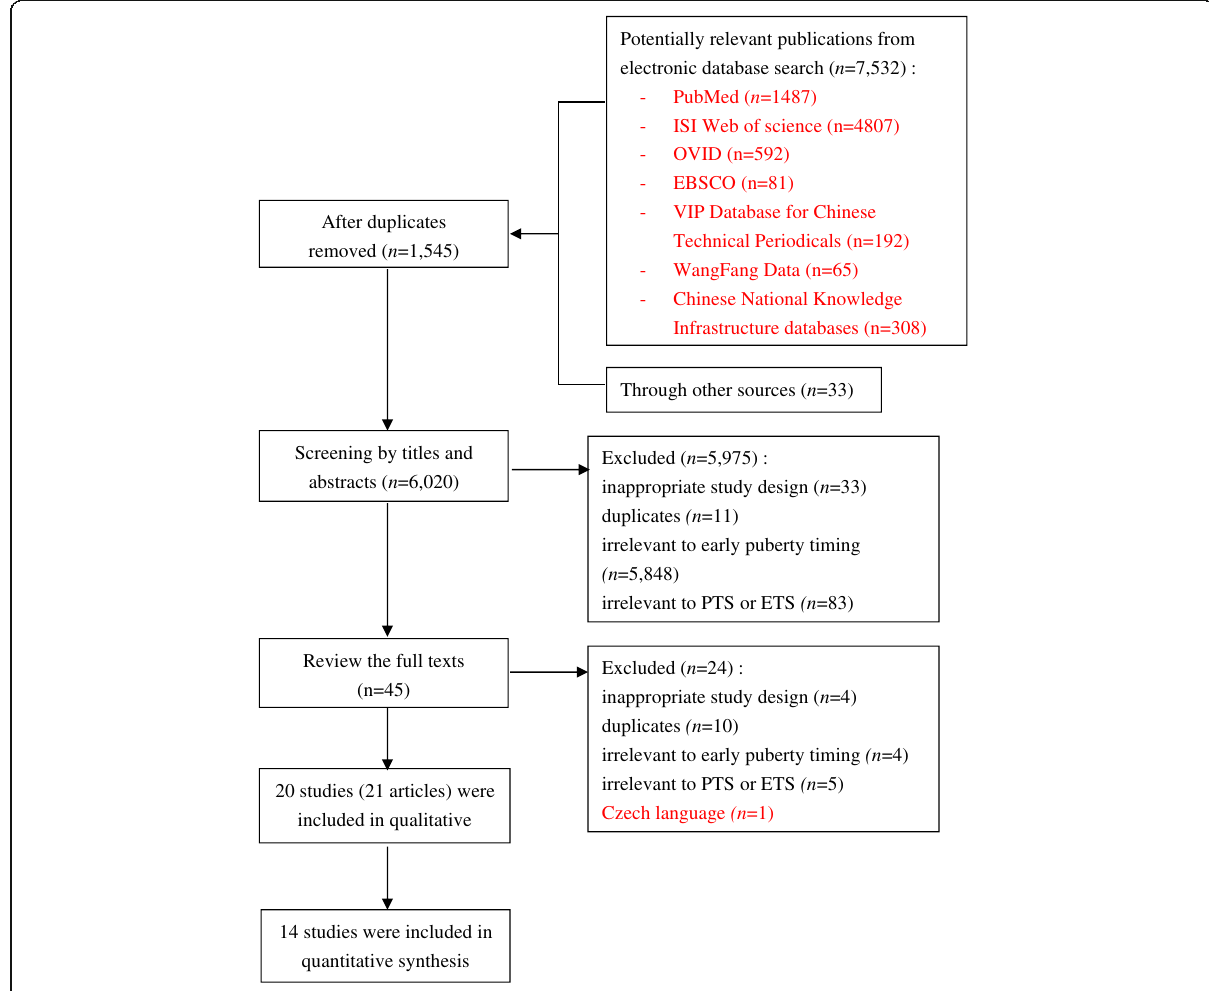
Fig. 1 Flow diagram of the literature